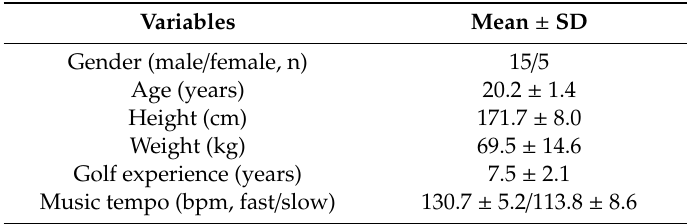
Table 1. Physical characteristics of